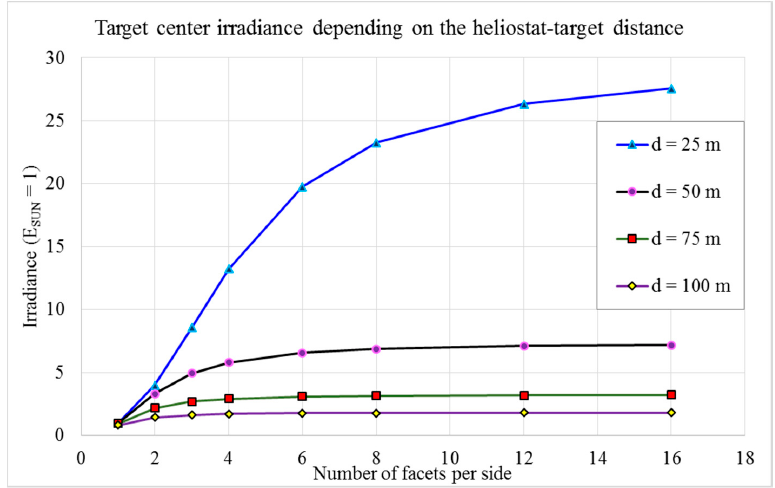
Figure 8. Irradiance in the target center for different heliostat-target distances d .